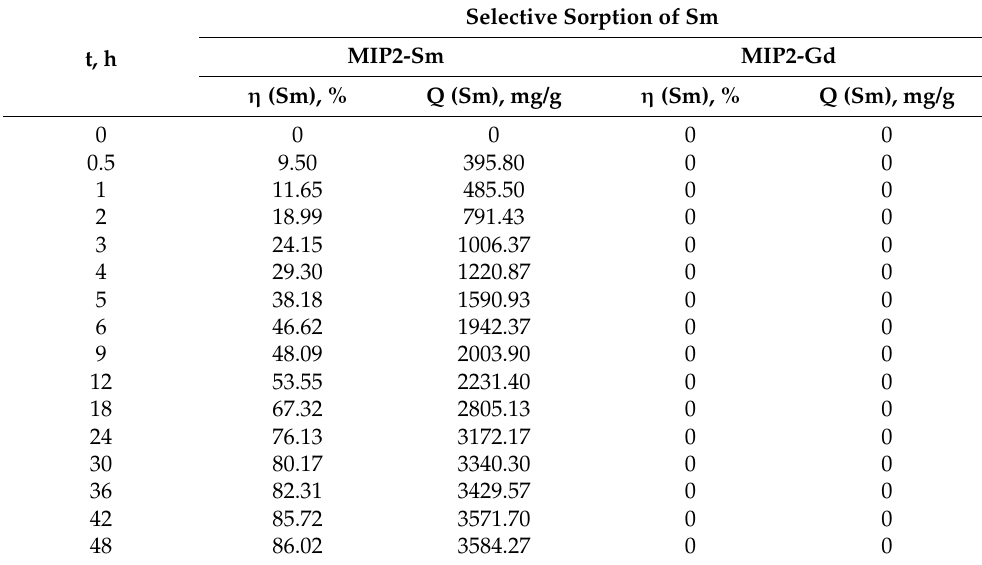
Table 10. Sorption properties of the MIP2-Sm and MIP2-Gd structures during selective sorption of